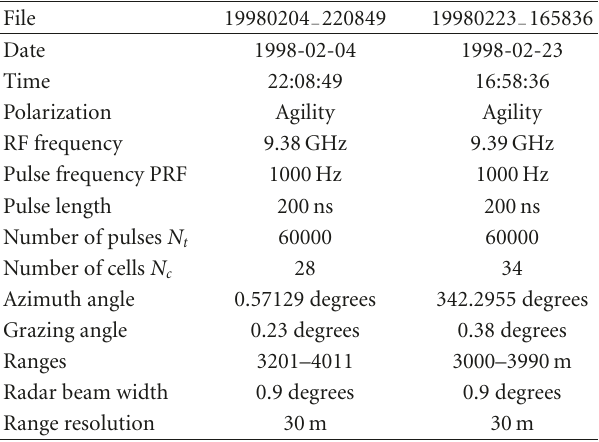
Figure 9: Test statistic (using bootstrap ACE) versus range in homogeneous K -distributed clutter, where ν = 0 . 5, μ = 1, N = 8, K = 64, and P e = 0 . 025. Table 8: Specifications of the sea clutter data.